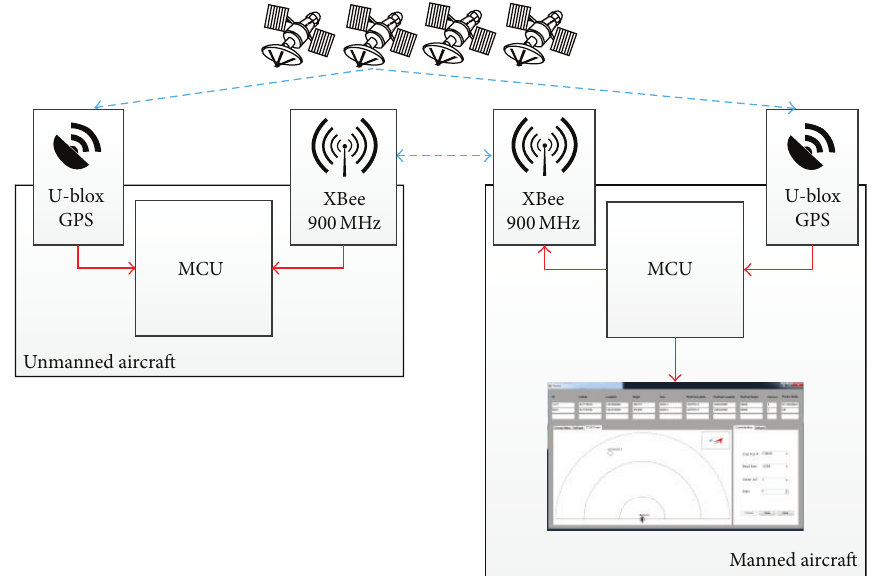
Figure 3: UAV/CD&R in ADS-B hardware.